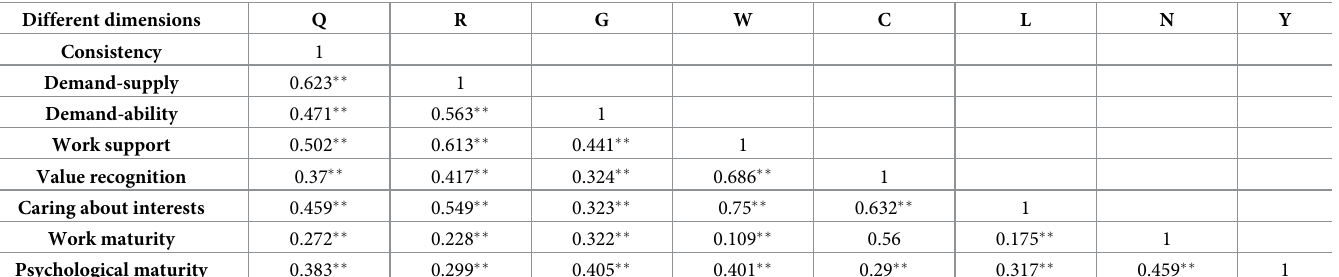
Table 3. Correlation statistical anWEalysis results of each variable. Different